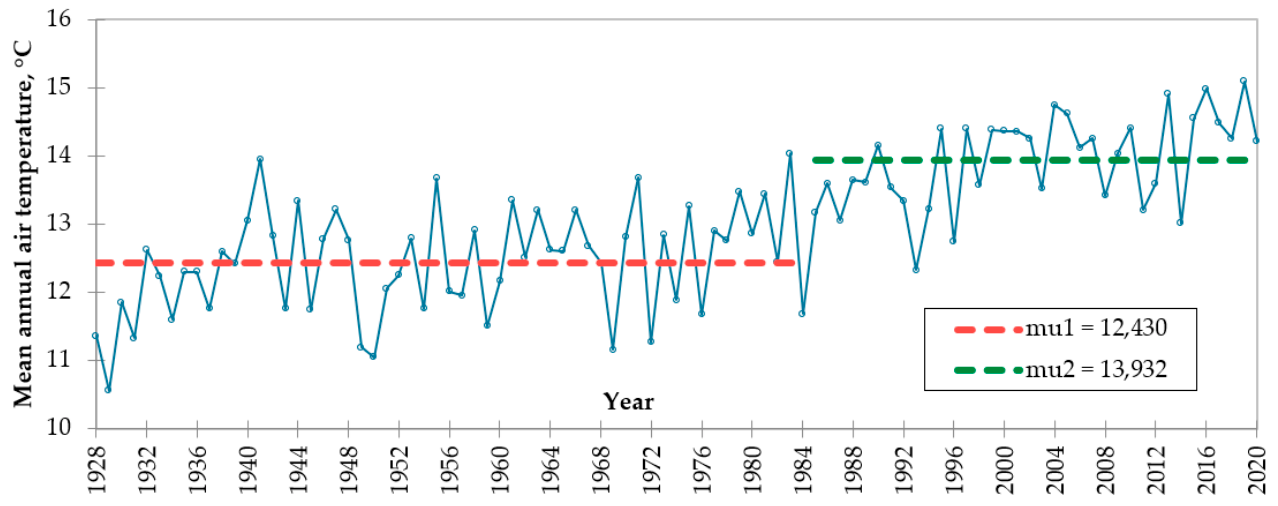
Figure 2. Mean annual air temperature at the Khiva meteorological station in 1928–2020 (point of change in 1984).